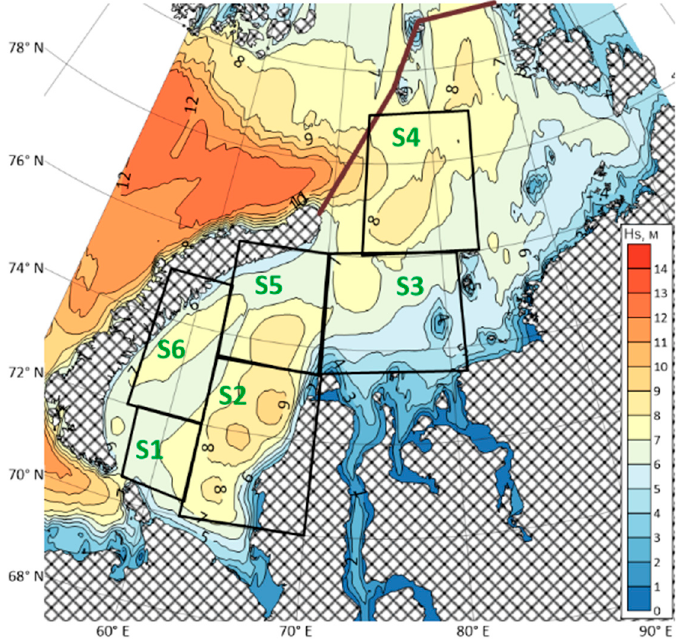
Figure 13. The SWH maximum and segmentation of the Kara Sea: Six sectors with different wave conditions. A catalog of storms with SWH more than 3 m was formed for each sector shown in